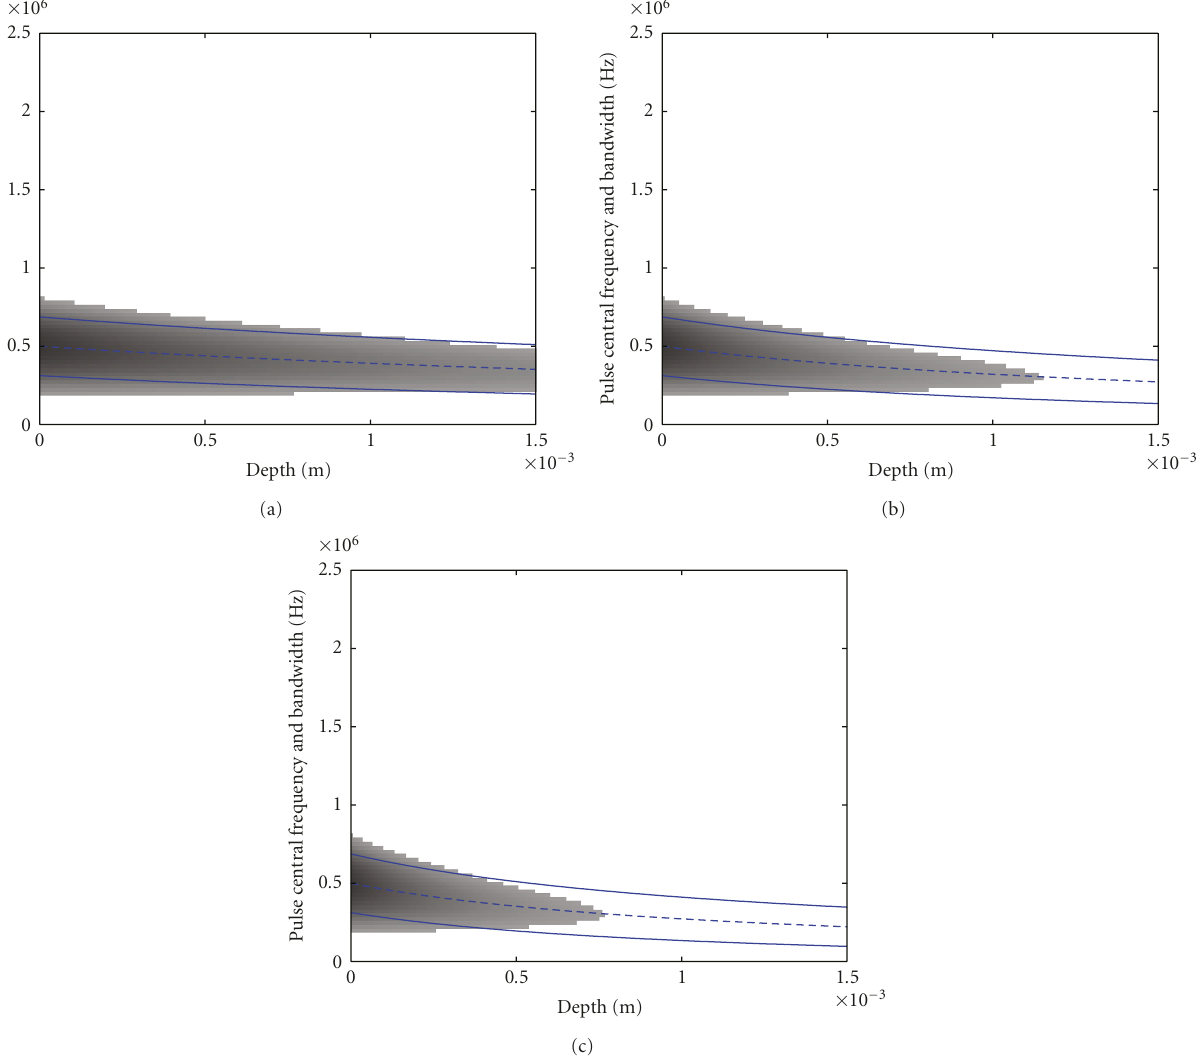
Figure 1: Simulations of the proposed model for Stochastic scattering attenuation. Simulation parameters of the ultrasonic pulse were central frequency f c = 500 KHz, fractional bandwidth B = 75%, and mean scatterer size D = { 0.5, 1 and 1.5 mm } . (a) D = 0.5mm, (b) D = 1mm, and (c) D =